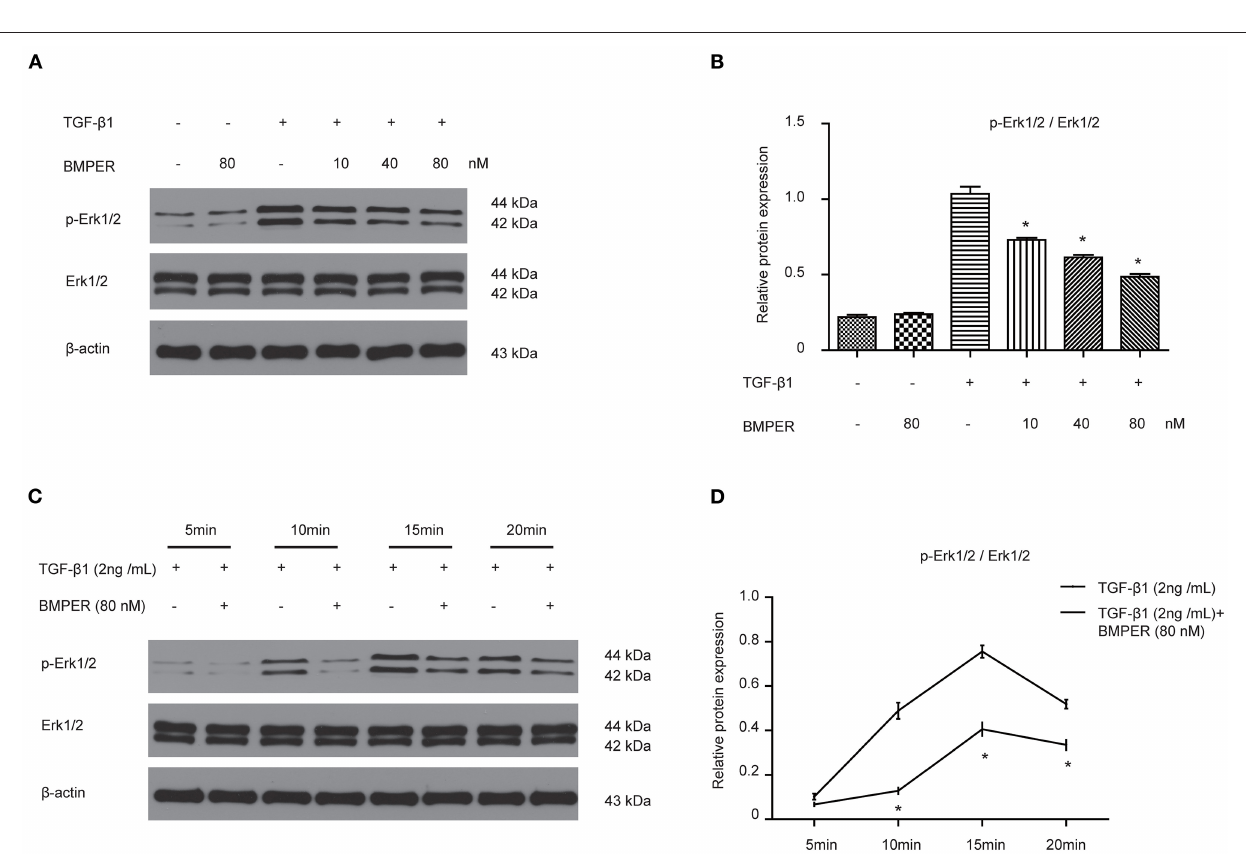
FIGURE 5 | BMPER inhibited Erk1/2 phosphorylation in NRK-49F cells. NRK-49F cells were incubated with 2ng/ml TGF- β 1 and increasing amounts of BMPER as indicated for 20min, and Erk1/2, p- Erk1/2 were measured by Western blot (A) . The relative protein expression for p-Erk1/2 / Erk1/2 in NRK-49F cells was displayed (B) . NRK-49F cells were treated with TGF- β 1 (2ng/ml) or TGF- β 1 (2ng/ml) plus BMPER (80nM) at indicated time, and Erk1/2, p- Erk1/2 were measured by Western blot (C) . The relative protein expression for p-Erk1/2 / Erk1/2 in NRK-49F cells was displayed (D) . Values are the means ± SEM ( n = 3). * p < 0.05 vs. TGF- β 1